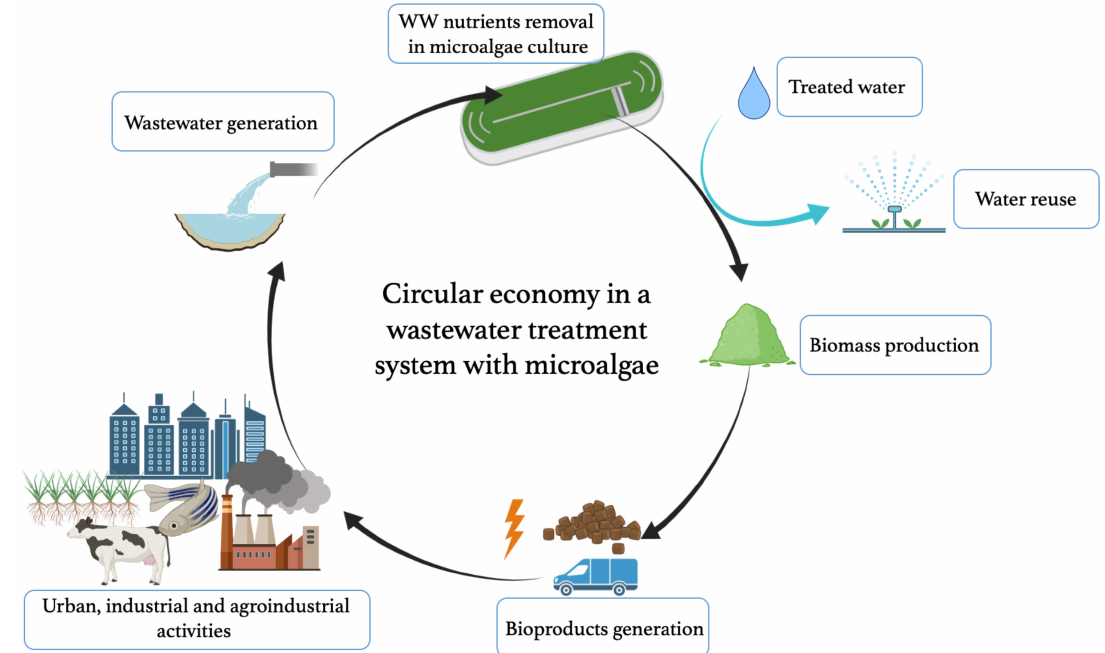
Figure 4. Circular economy in a wastewater treatment system with microalgae. This figure was made with